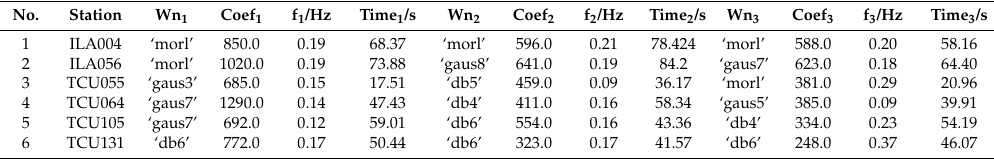
Table 4. The wavelet parameters for the earthquake motions qualified as pulse-like with three mother wavelets.